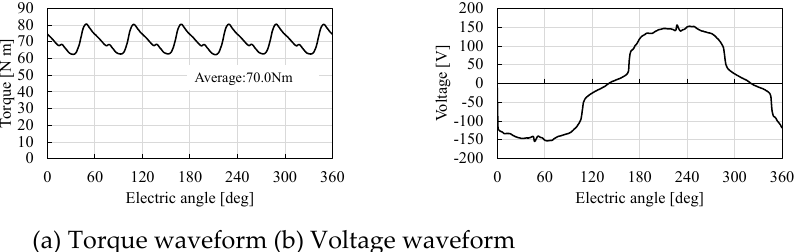
Figure 8. Torque waveform and phase voltage waveform in rotation speed of 11,500 min − 1 , input current of 356 Arms, and beta angle of 0 degrees.